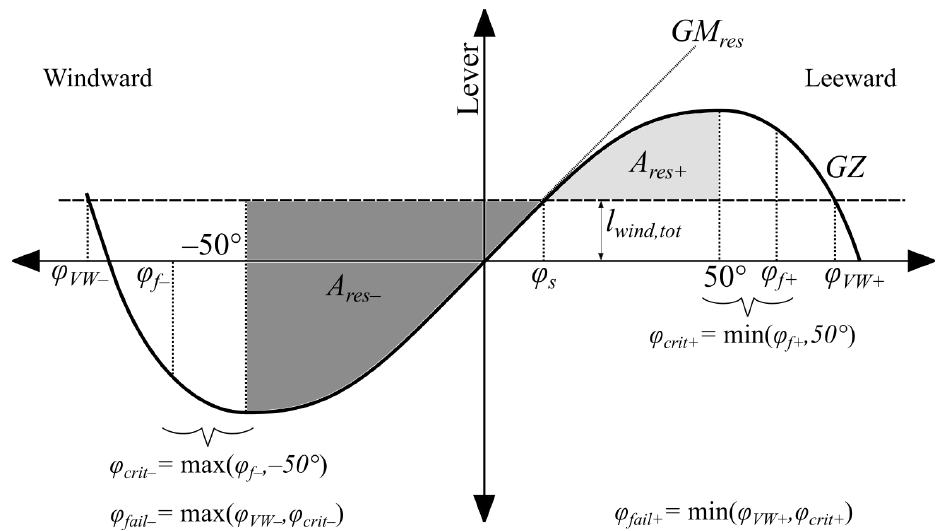
Figure 4. Dead ship level 2 equivalent righting arm area